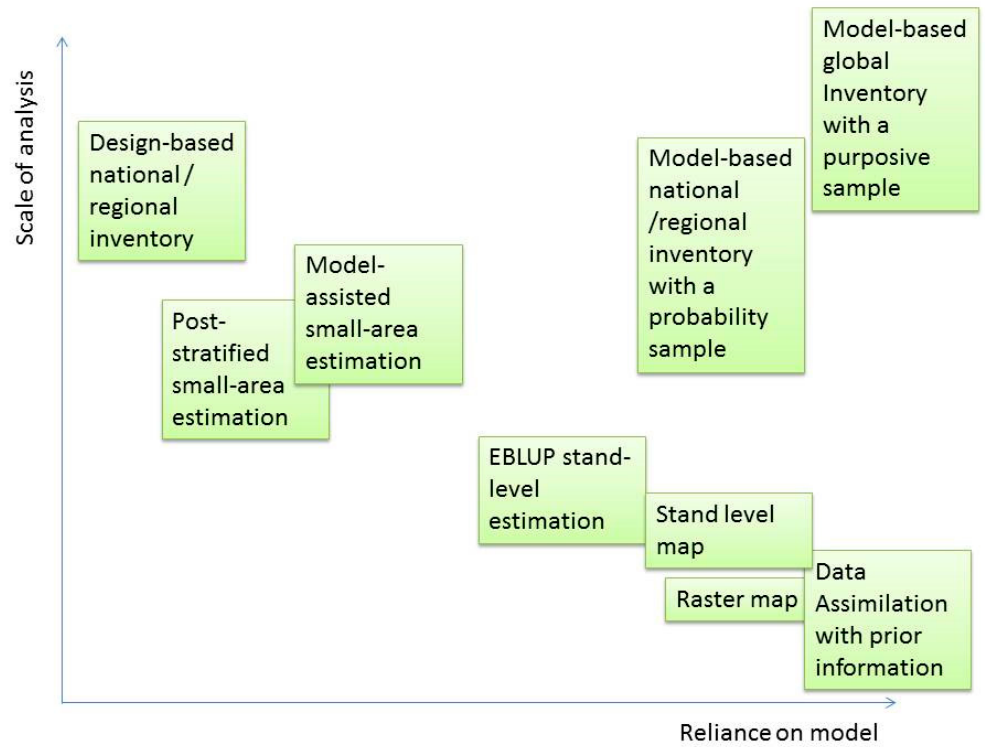
Figure 1. The usefulness of the design-based and model-based approaches on different scales.